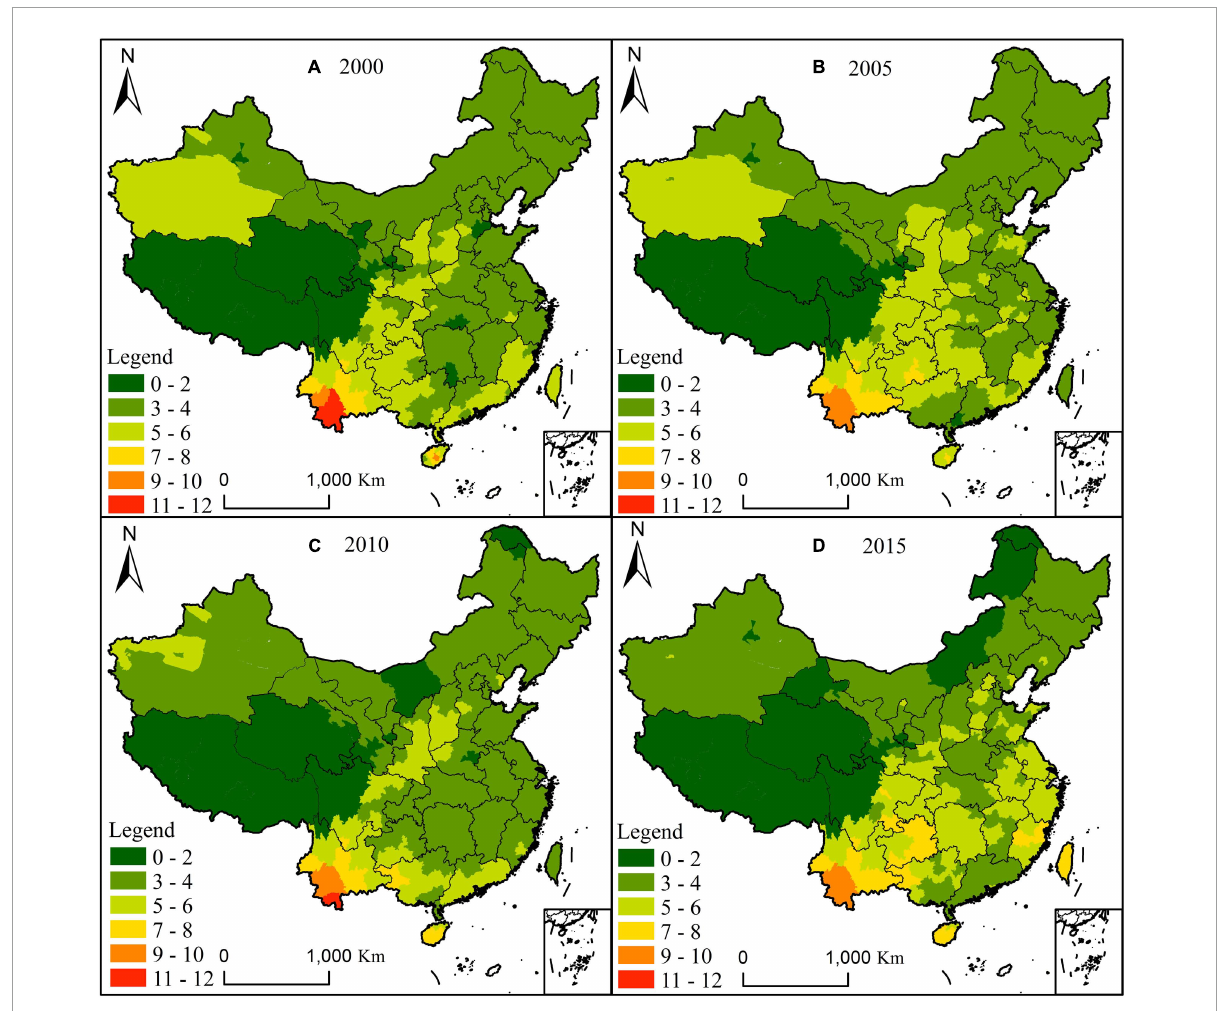
FIGURE3 Monthly change in human settlement climate comfort in China from 2000 to